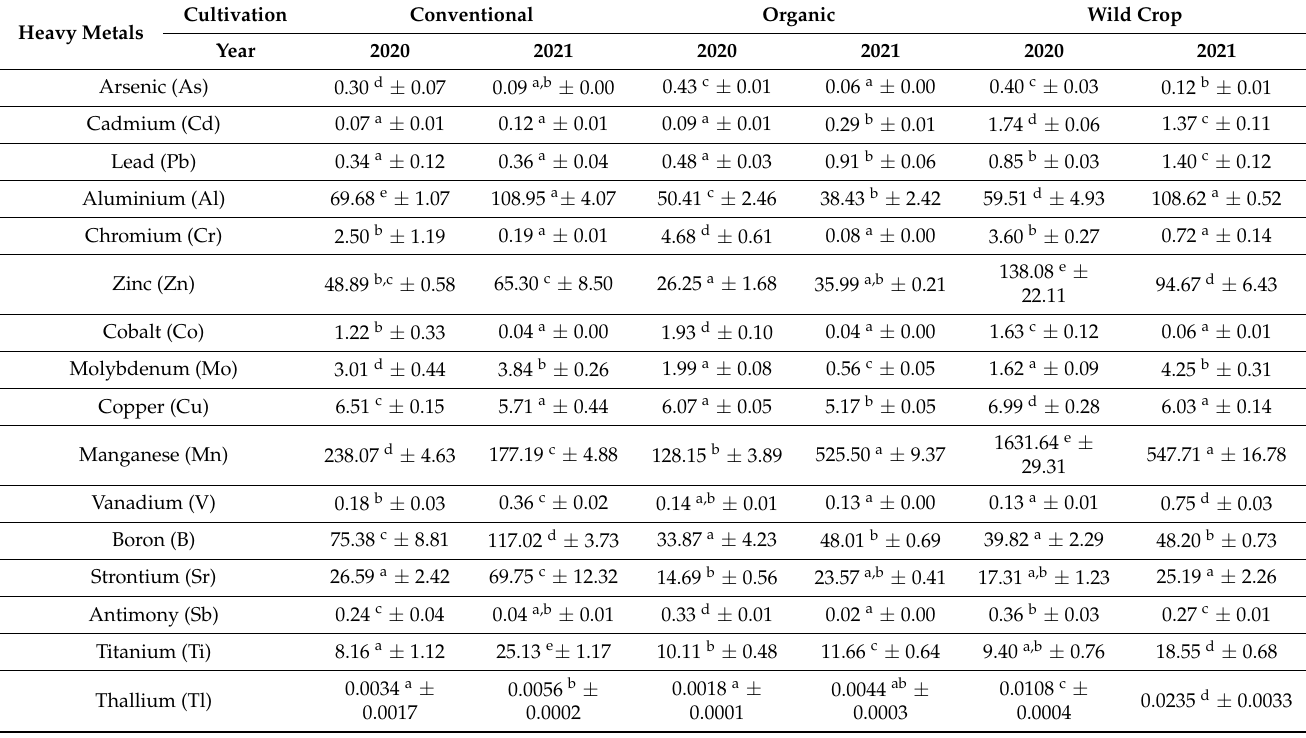
Table 2. The content of selected heavy metals in raspberry leaves from organic, conventional and wild plants (mg kg − 1 dry